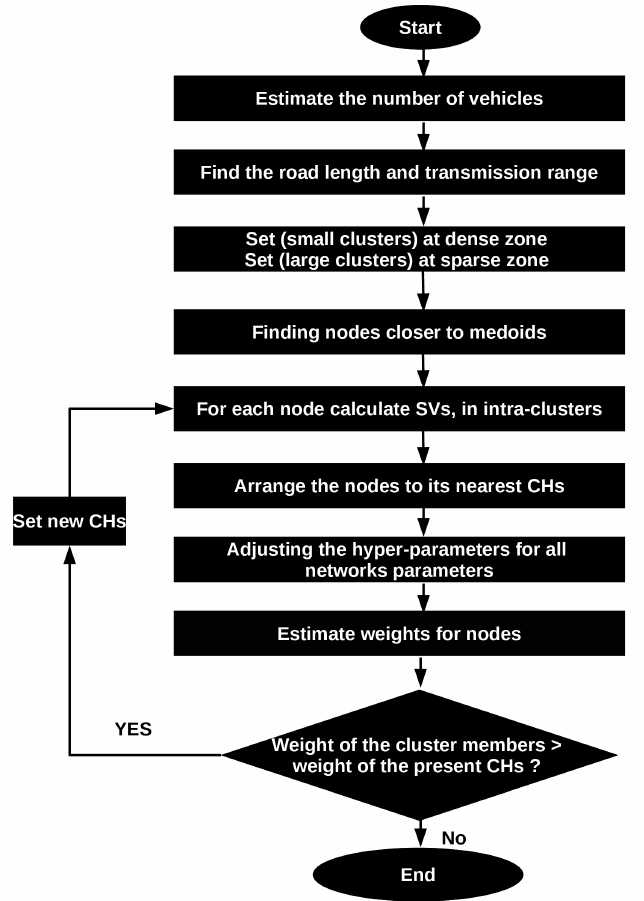
Figure 5. Workflow of Proposed